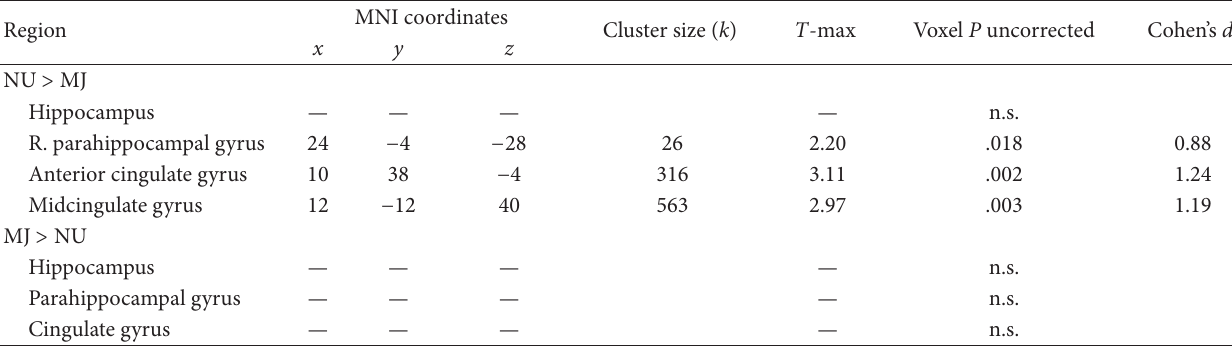
T 4: Region of interest analysis of bold activation—Retrieval-Motor